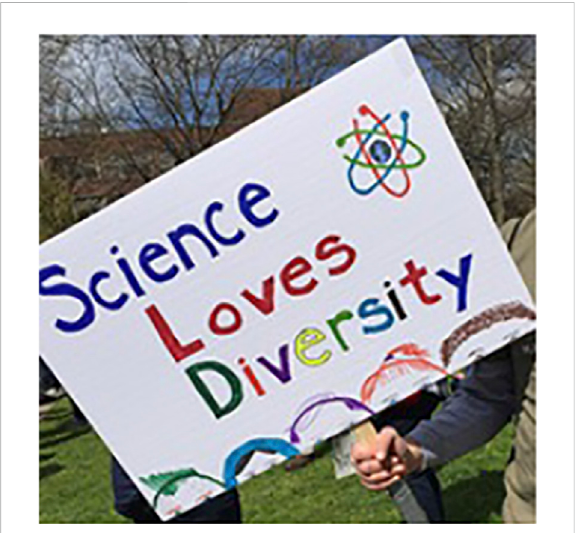
FIGURE 1 The sign the author made when he participated in the March for Science walk on Earth Day in